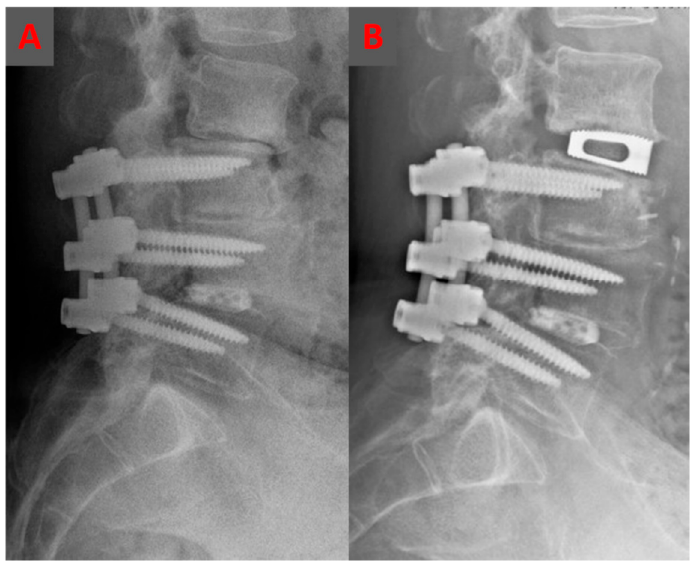
Figure 1. An illustrative case showing a preoperative lateral lumbar radiograph of a 69-year-old man following a posterior L3–L5 fusion 4 years ago and a severe disc degeneration, and retrolisthesis present at L2–L3 ( A ). The patient underwent a stand-alone oblique lumbar interbody fusion at L2–L3 with restoration of lumbar lordosis and intervertebral disc heights ( B ). Table 4. Radiological outcomes.